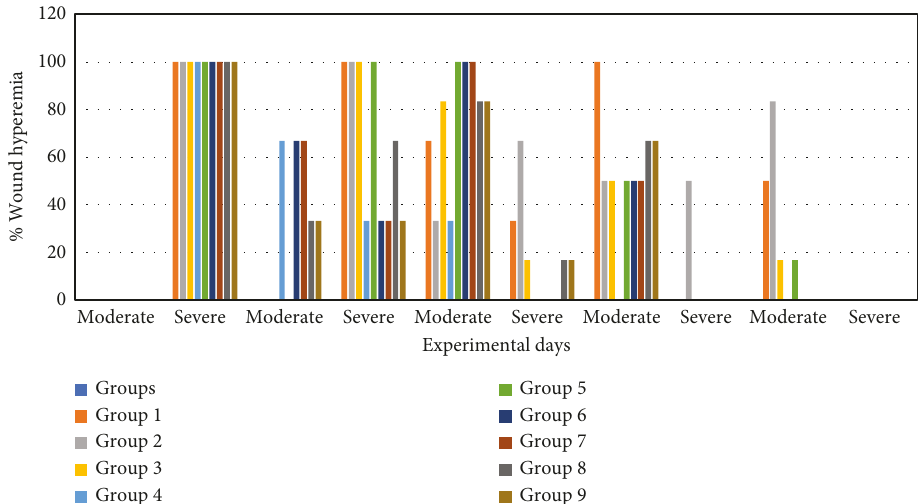
Figure 7: Wound hyperemia (%) in experimental groups on days 3, 6, 9, and 12 after wounding.